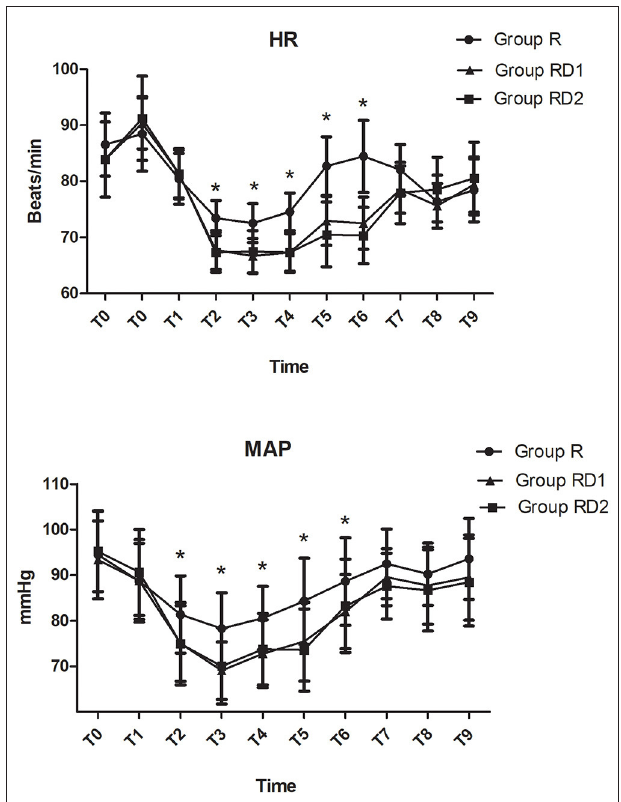
FIGURE 2 | Intraoperative hemodynamic changes. T0, arrival at the operating room; T1, before intubation; T2, after intubation; T3, before incision; T4, 30min after one-lung ventilation; T5, extubation; T6, 1h post-operatively; T7, 4h post-operatively; T8, 8h post-operatively; T9, 12h post-operatively. * P < 0.05 vs. group